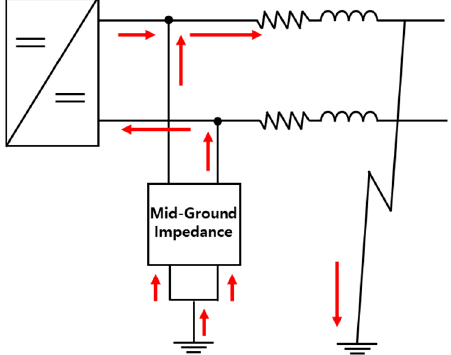
Figure 11. Fault current path for the mid ‐ point ground system with capacitors.